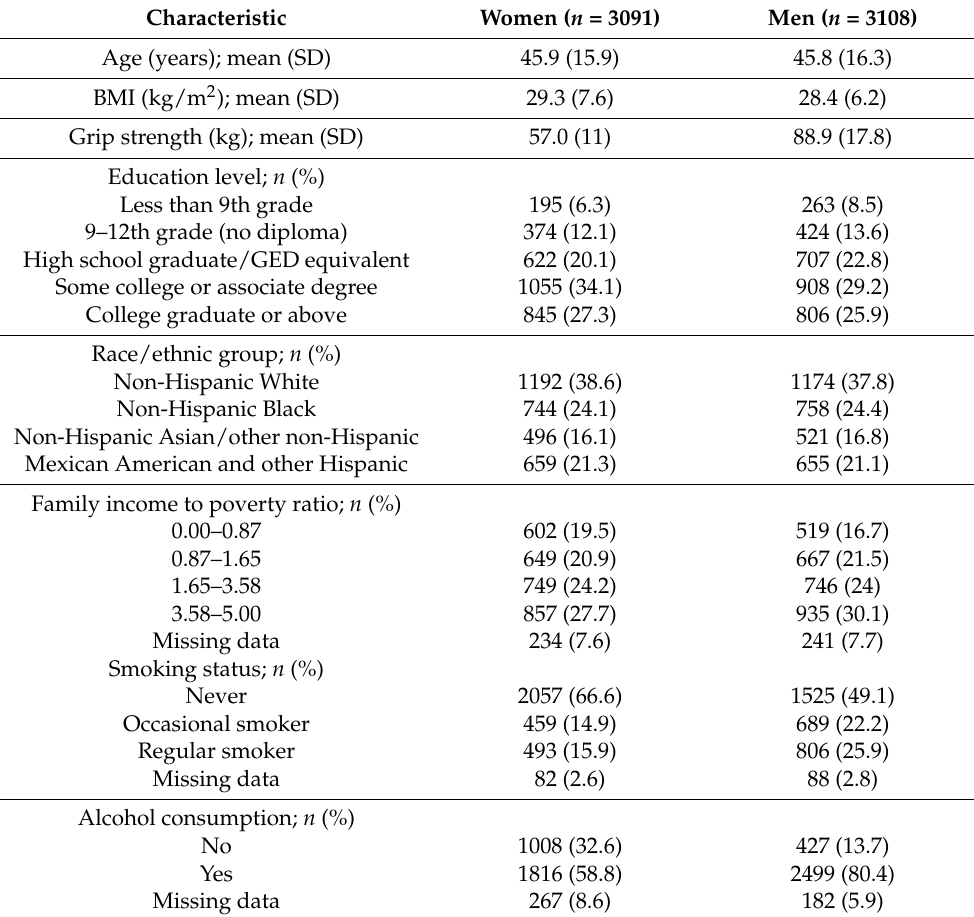
Table 1. Description of the study population stratified by sex.